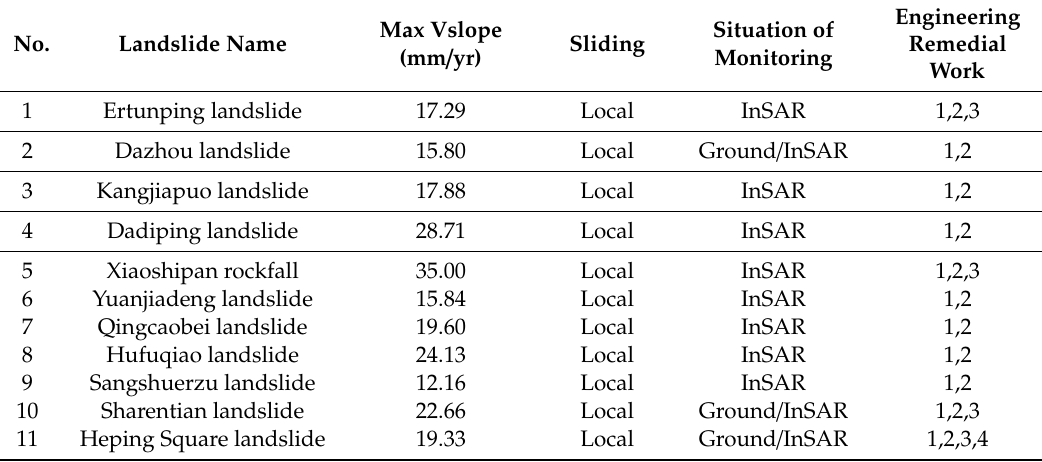
Table 3. The maximum slope displacement velocity of controlled landslides acquired by PSInSAR (PSI interferometric synthetic aperture radar) time-series analysis.